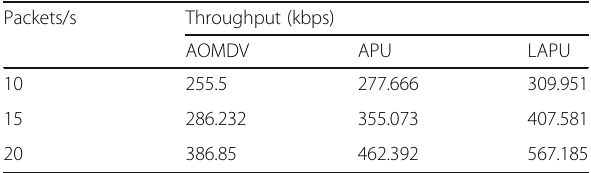
Table 5 Average energy consumption vs. data rates